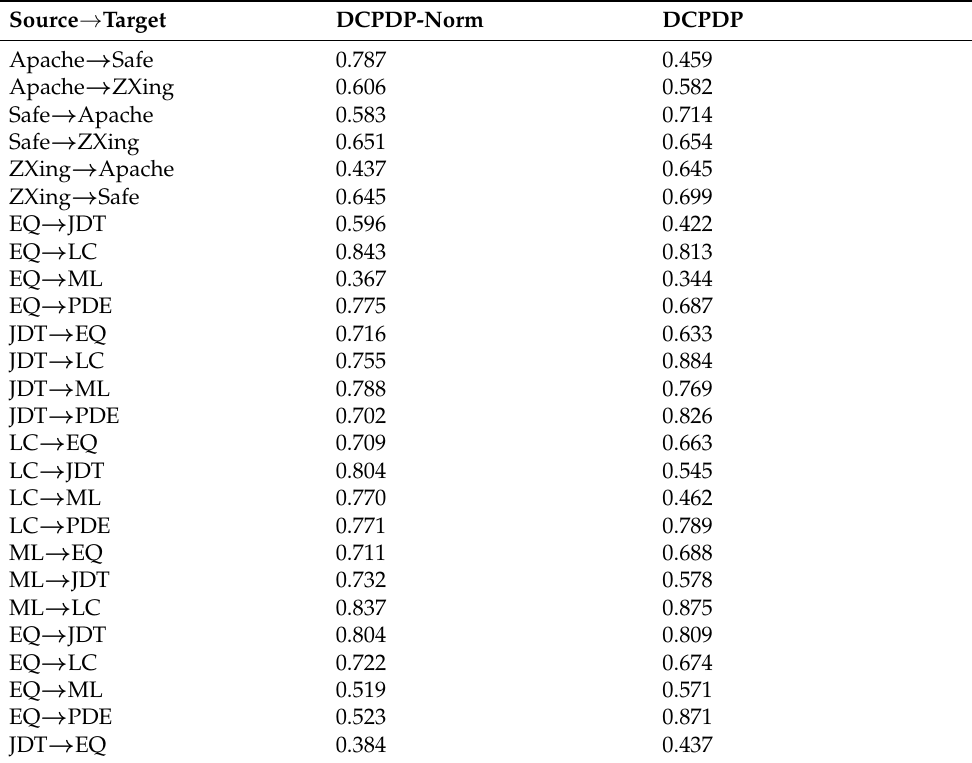
Table 2. Comparison of F1 values between DCPDP-Norm and DCPDP.